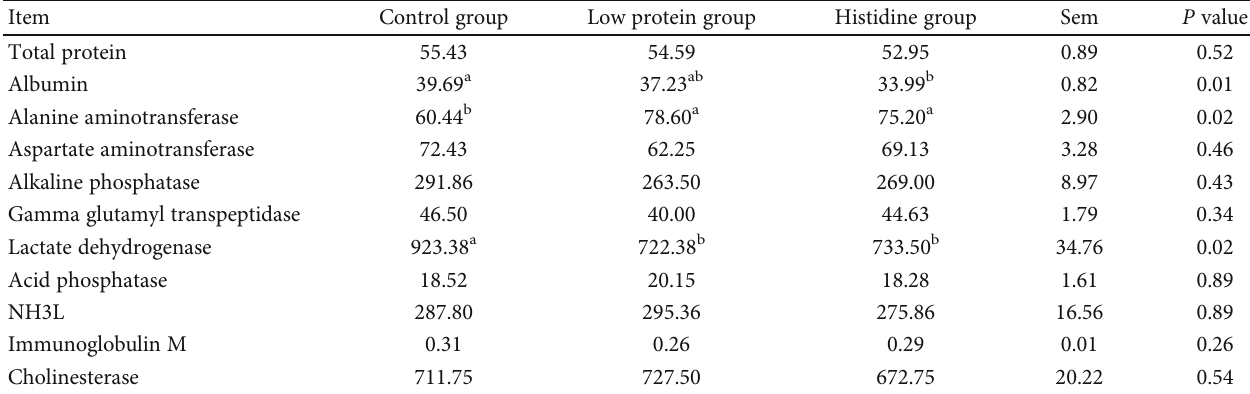
Table 3: E ff ect of dietary histidine on serum biochemical indexes in low protein diet-fed